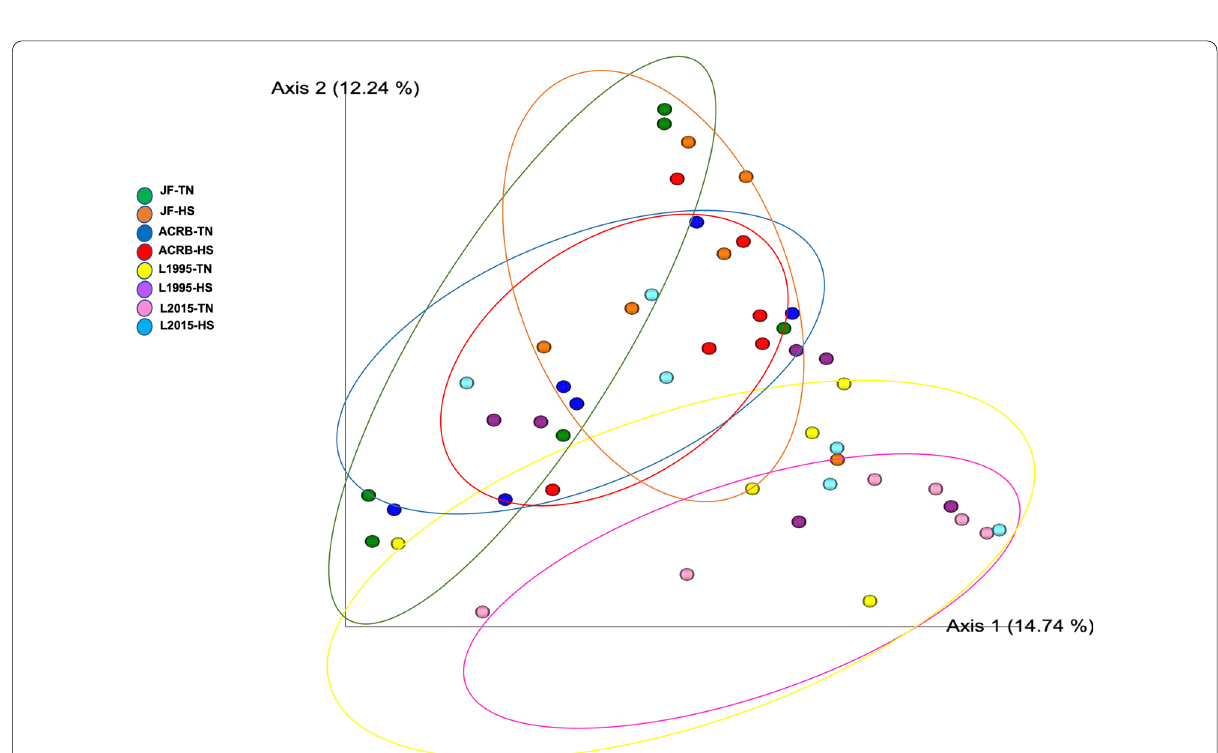
Fig. 8 Beta diversity in the ileal mucosa of Jungle Fowl (JF), Athens Canadian Random Bred (ACRB), 1995 Random Bred (1995), and 2015 Modern Random Bred (2015) chicken lines raised under thermoneutral (TN) or heat stress (HS) condition on d 56. 2D principal coordinate analysis (PCoA) plot is based on weighted UniFrac distance matrix. Each sphere represents a